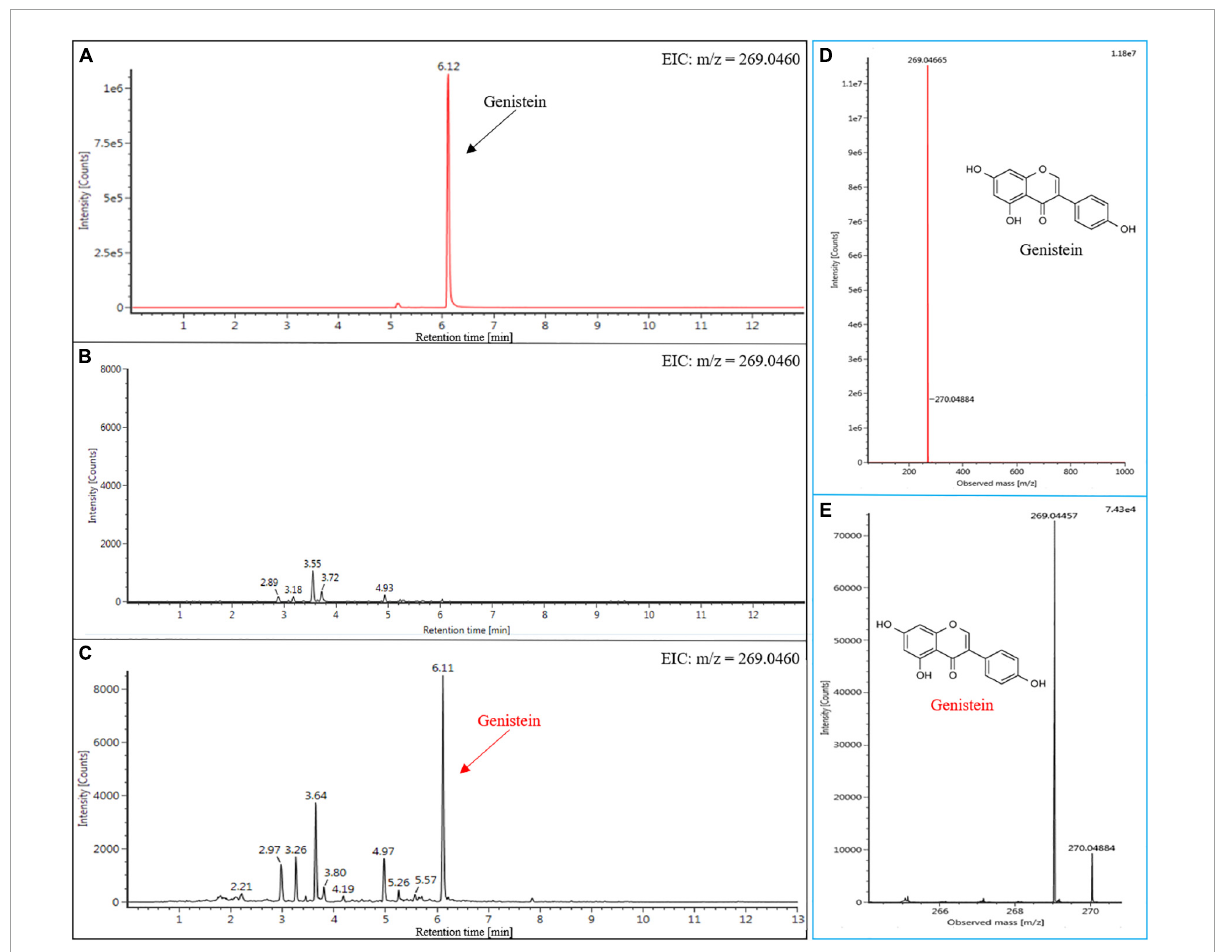
FIGURE5 UPLC-MS analysis of genistein in the leaf extracts from infiltrated N . benthamiana (Detection wavelength, 254 nm). The EIC ( m/z = 269.0460) of the genistein in the standard sample (A) , WT (B) , and infiltrated N . benthamiana (C) . MS fragmentation patterns of (-)-genistein in the leaves of infiltrated N . benthamiana (E) , and it was identical to the genistein standard (D)